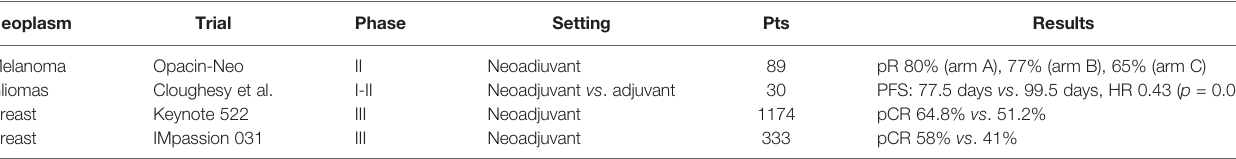
TABLE 1 | Published trials of immunotherapy in early stage on most common AYAs neoplasms. Neoplasm